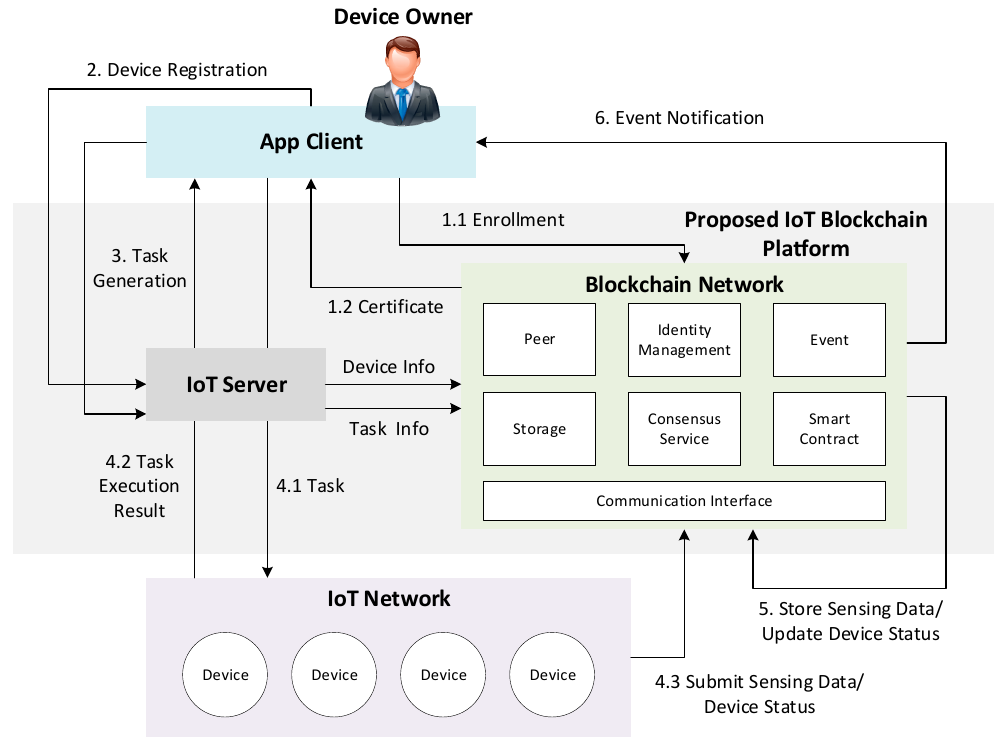
Figure 3. System work flow of the proposed IoT blockchain platform.